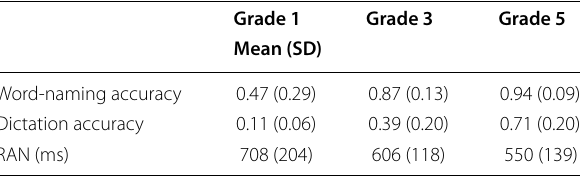
Table 1 Means of RAN, reading, writing, and performance in first, third, and fifth